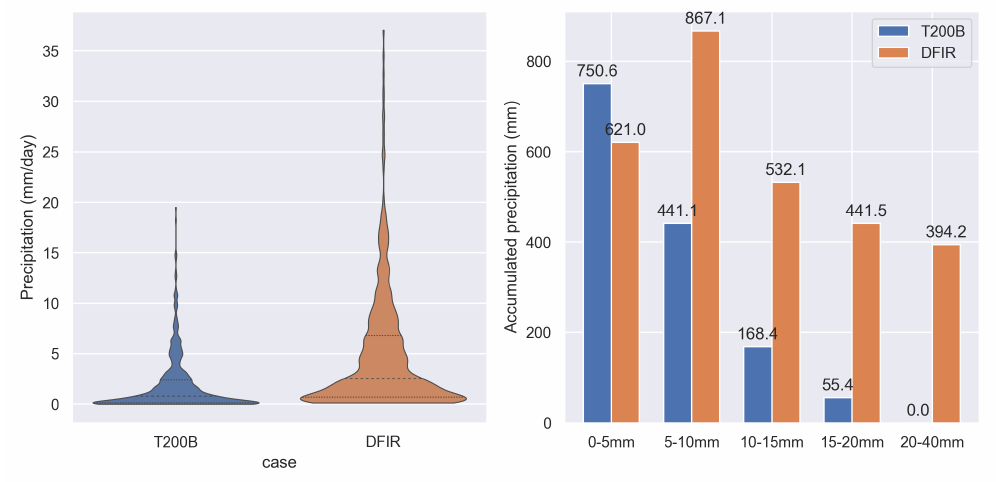
Figure 3. Comparison between the T200B and DFIR observations of precipitation. The ( left ) is the frequency distribution of the two types of observations. The ( right ) is the segmented statistical precipitation for the two types of